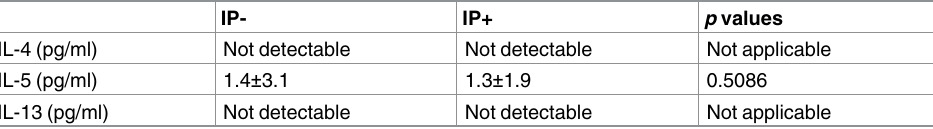
Table 6. Comparison of Th2 cytokine levels.